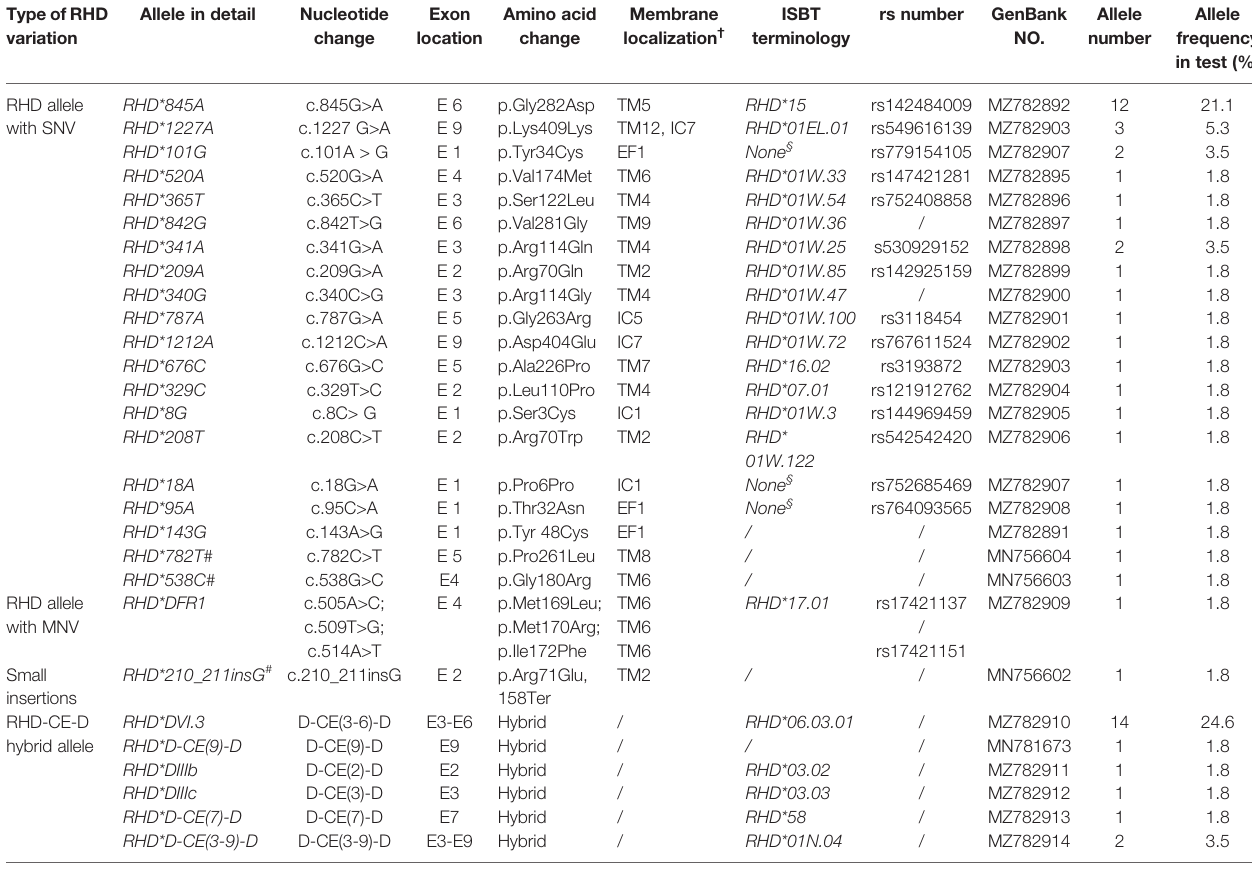
TABLE 2 | RHD alleles in a cohort of Chinese individuals with RhD variant phenotypes ( n =52). TypeofRHD